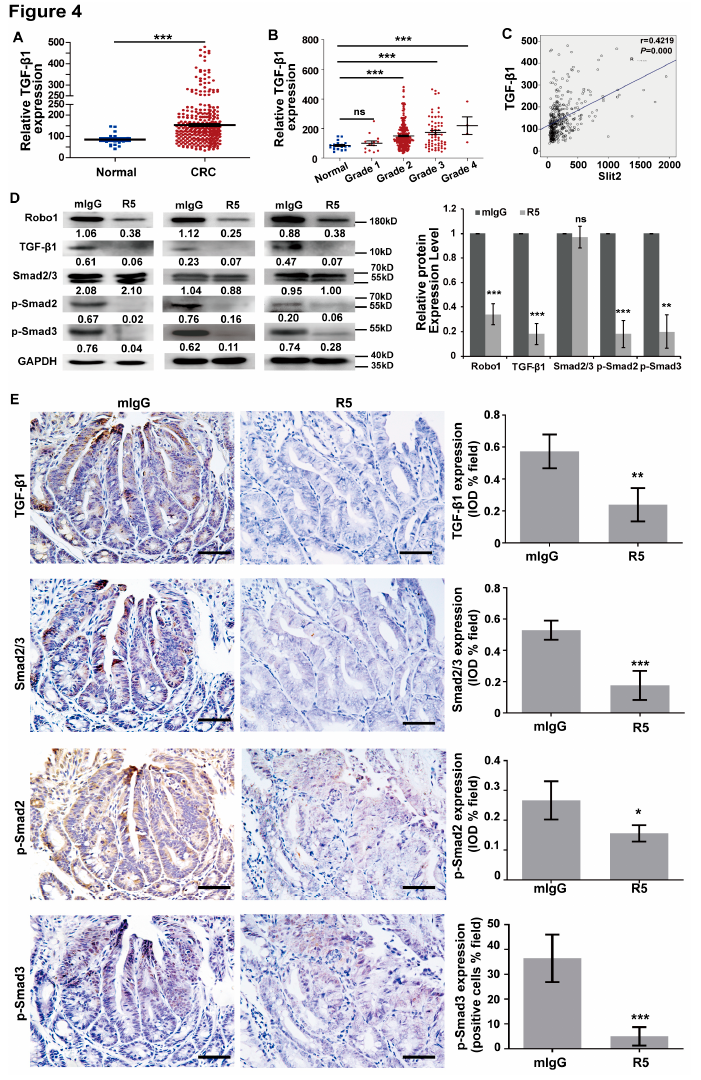
/ Smad2 / 3 pathway is correlated with Slit2 / Robo1 signaling in CRC. ( A ) Relative and and Figure 4. The TGF- β 1 TGF- β 1 expression, taken from the MERAV database, is significantly increased in primary tumor tissues of CRC patients ( n = 321) compared with normal samples ( n = 19). ( B ) Relative TGF- β 1 expression is gradually upregulated with the increase of the pathological grade in primary CRC patients from the MERAV database. There is no statistical di ff erence in TGF- β 1 expression, as shown by the t -test, between the normal group ( n = 19) and grade 1 primary CRC patients ( n = 13). A significant increase of TGF- β 1 expression can be seen between the normal group and grade 2 ( n = 241), grade 3 ( n = 63), and grade 4 ( n = 4) primary CRC patients. ( C ) The relationship between TGF- β 1 and Slit2 was analyzed using the MERAV database. TGF- β 1 expression was positively correlated with Slit2. ( D ) The protein expression of the TGF- β 1 / Smads signaling pathway in Lovo cells, which were treated with mIgG or R5, were detected by the Western blotting assay. The protein bands were quantified densitometrically using Quantity One software and normalized to GAPDH expression. The blocking of Slit2 / Robo1 signaling using R5 significantly inhibits the expression of TGF- β 1 and phosphorylated Smad2 / Smad3 compared with in mIgG-treated Lovo cells. ( E ) The protein expression of the TGF- β 1 / Smads signaling pathway in tumor tissues of mIgG- or R5-treated Apc Min /+ mice was detected by the IHC assay. The protein expression levels in slices were quantified using IPP software. ns: no significant di ff erentiation, *: p < 0.05, **: p < 0.01, ***: p <